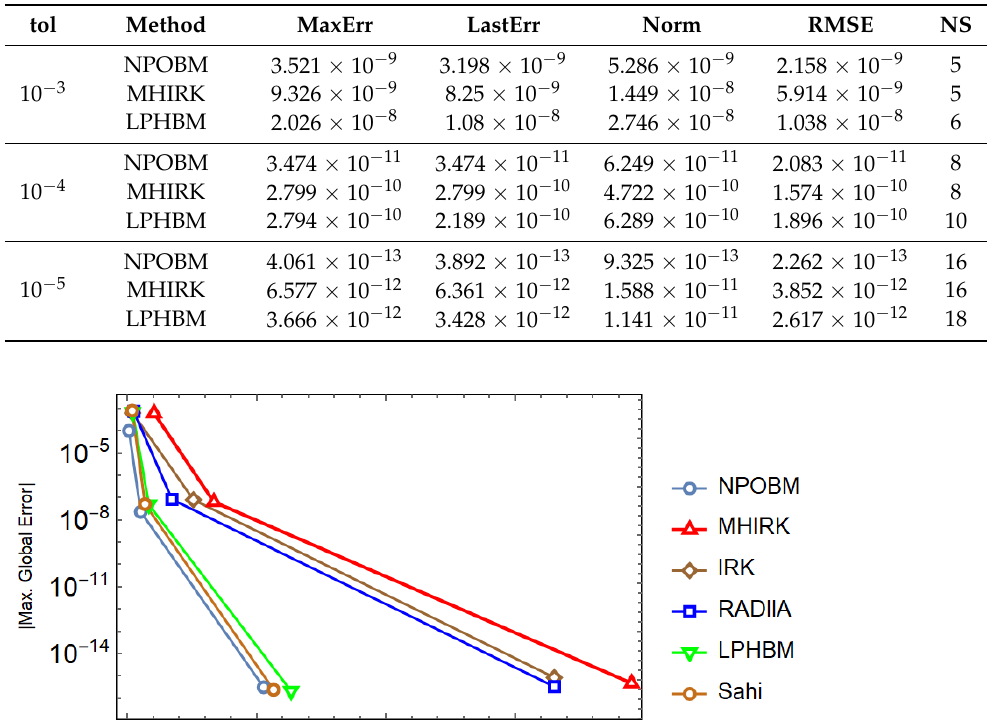
Table 4. Numerical results for Problem 1 with adaptive step-size approach while ∆ x ini = 10 − 6 .